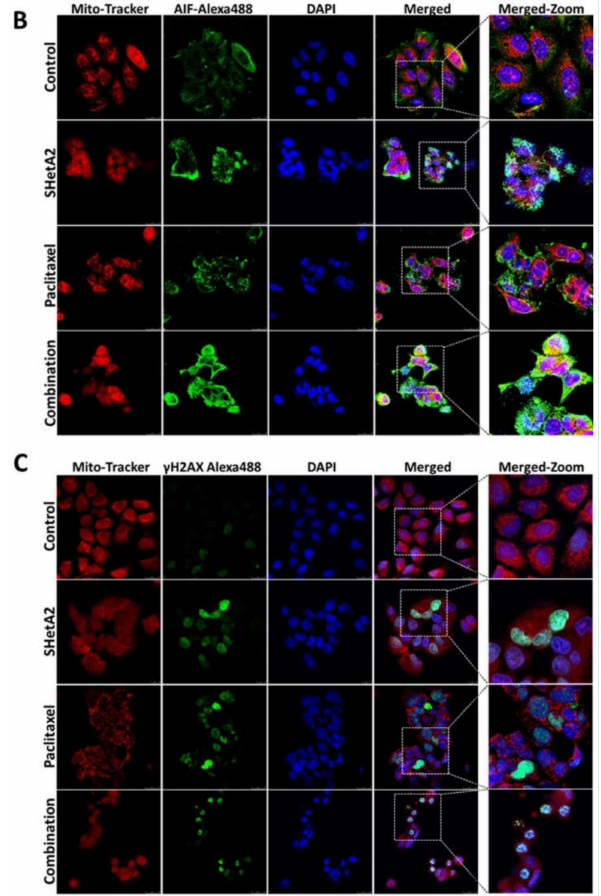
Figure 6. SHetA2 induces nuclear translocation of AIF, while both SHetA2 and paclitaxel induce DNA damage: ( A ) Western blot analysis for AIF expression in AN3CA and Ishikawa cells treated with SHetA2 or paclitaxel or their combination. ( B , C ) Representative immunofluorescence images for Mitotracker (red) and AIF (Green, B ), or γ H2AX ( C ) show their localization in AN3CA and Ishikawa cells treated with SHetA2 or paclitaxel or their combination. DAPI (Blue) staining was used as nuclear stain. Representative images taken at 63 × magnification are shown. The left-most panels represent enlarged pictures of the square boxes shown in merged